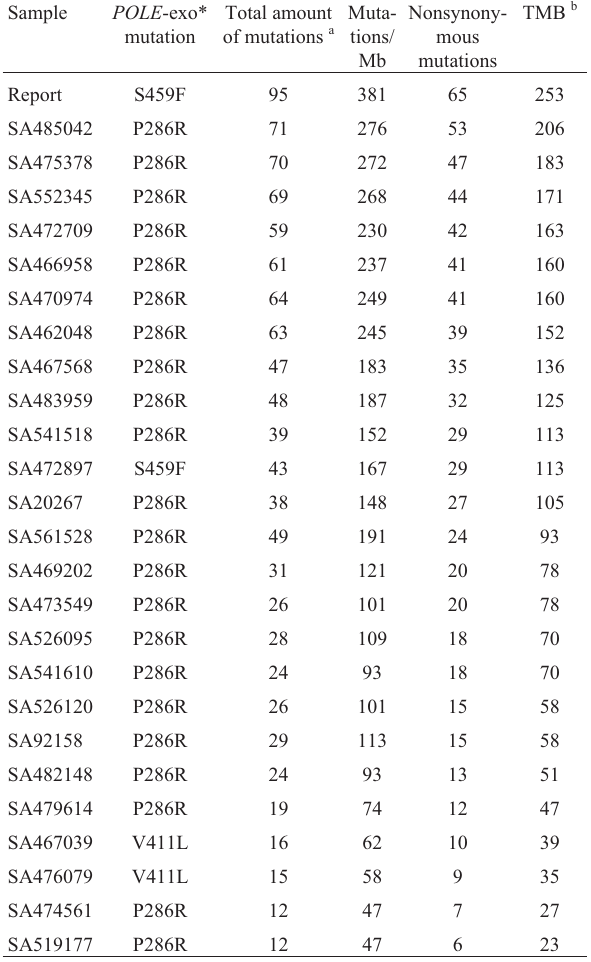
Table 1 - Mutational profile of endometrial carcinomas harboring hetero- zygous POLE -exo* mutations in comparison with the endometrial cancer